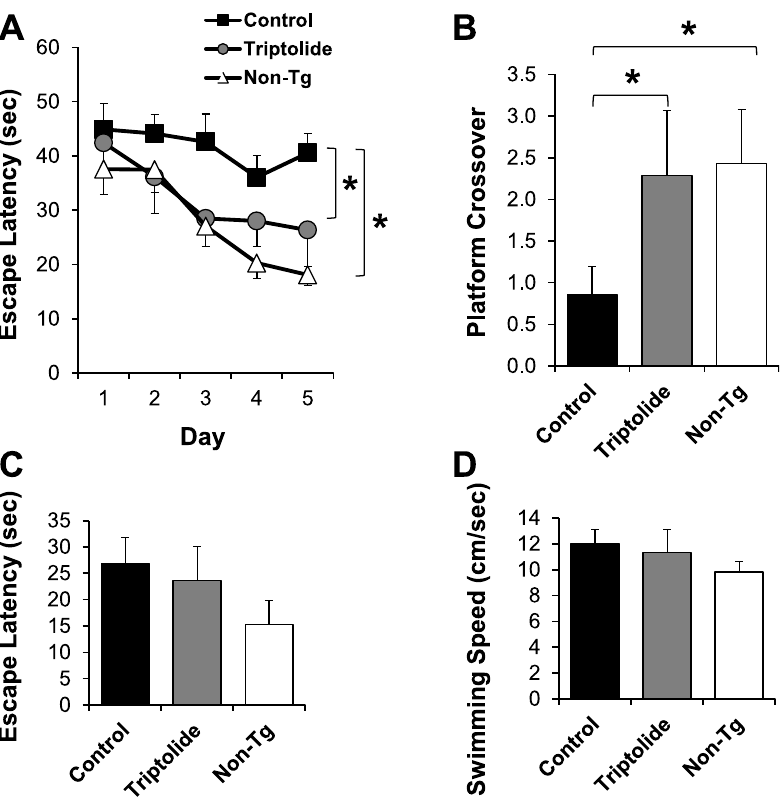
Figure 1. Triptolide treatment rescues spatial learning and memory deficits in APP/PS1 mice. A , Escape latency during the acquisition phase of the Morris water maze test. Untreated control APP/PS1 mice exhibited learning deficits in locating the submerged escape platform, whereas triptolide-treated mice performed similarly to non-Tg mice. B , The number of crossings over the previously hidden platform area in the probe trial. Triptolide-treated group crossed the platform area significantly more often than control APP/PS1 group. C and D , Escape latency and swimming speed during the visible platform phase of the Morris water maze test. No significant differences were observed among different groups. For clarity, error bars are shown in only one direction. N=7 mice/group; Age=8 months; *, P , 0.05.